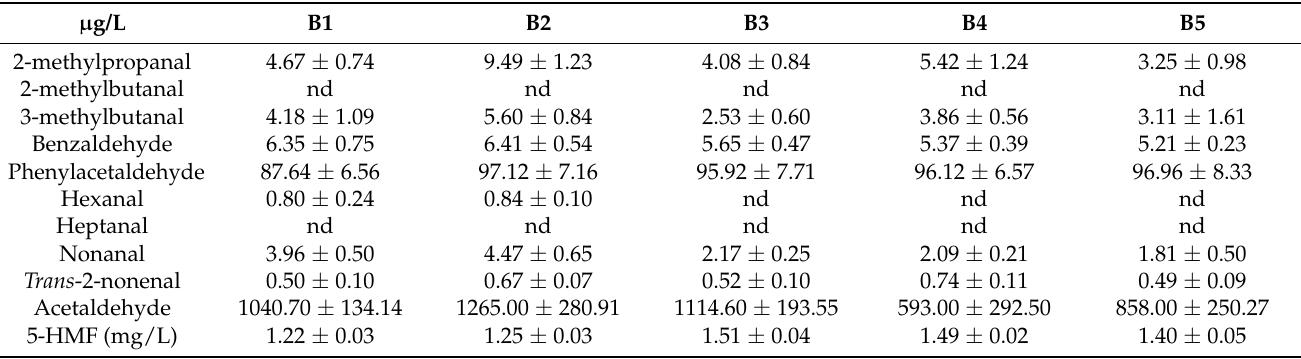
Table 1. Concentration of aldehydes in fresh lager beers (three beer samples per batch). Values expressed as mean value ± standard